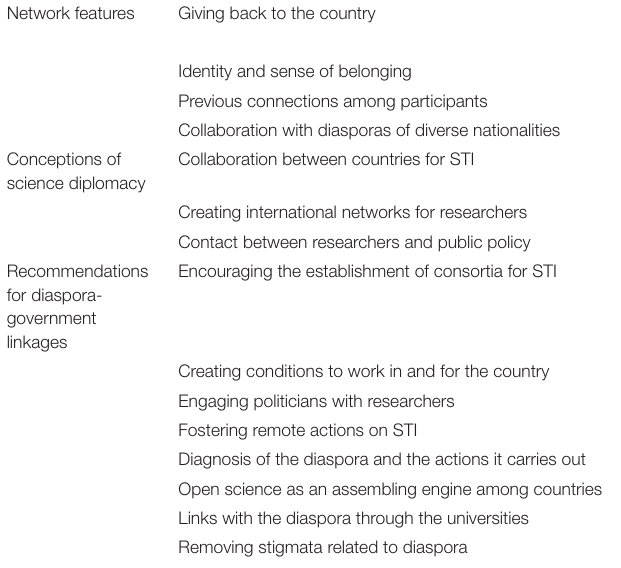
TABLE 5 | CEVALE2VE’s